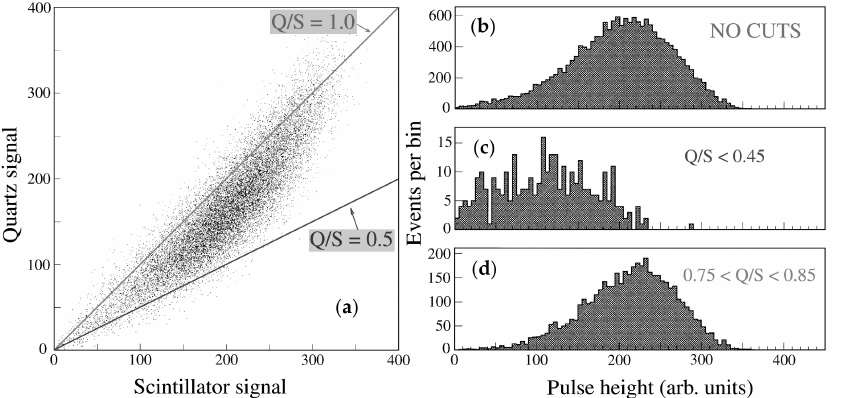
Figure 4. Results from measurements of the signals from 375 GeV π − sent into the 1.4 λ int thick ACCESS dual-readout calorimeter. See text for